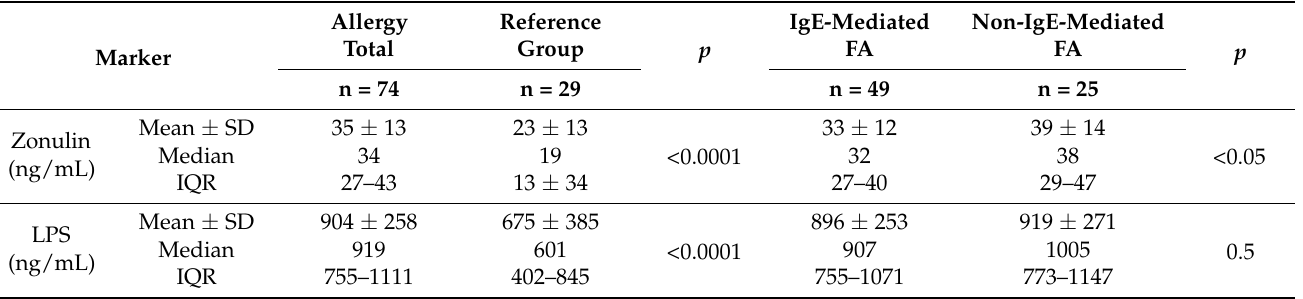
Table 2. Zonulin and LPS levels—comparison of all children with FA and reference group depending on the immune pathomechanism of FA.